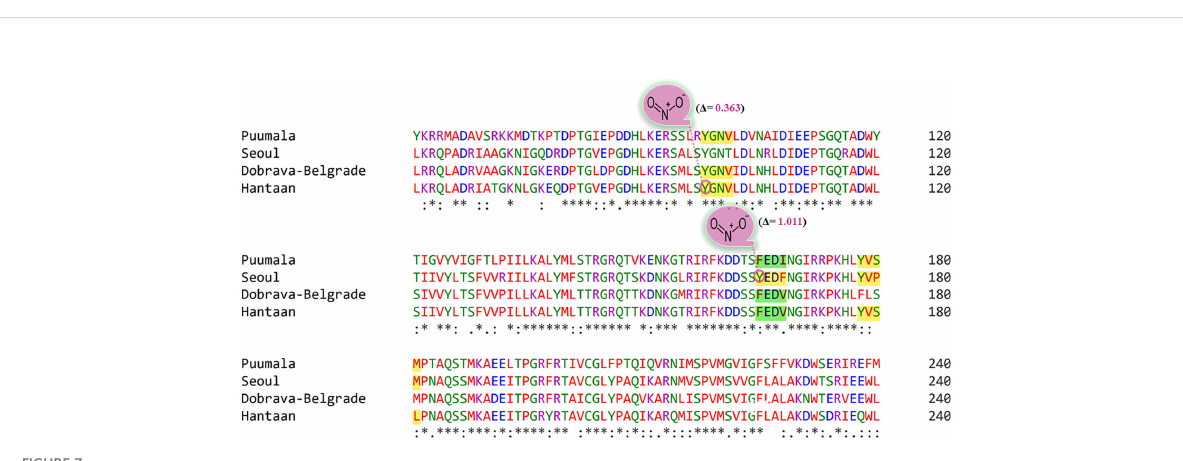
FIGURE 7 Graphical representation of putative nitrated residues within viral sequences. Stars, amino acid sequence similarity; colons, amino acid sequence difference.